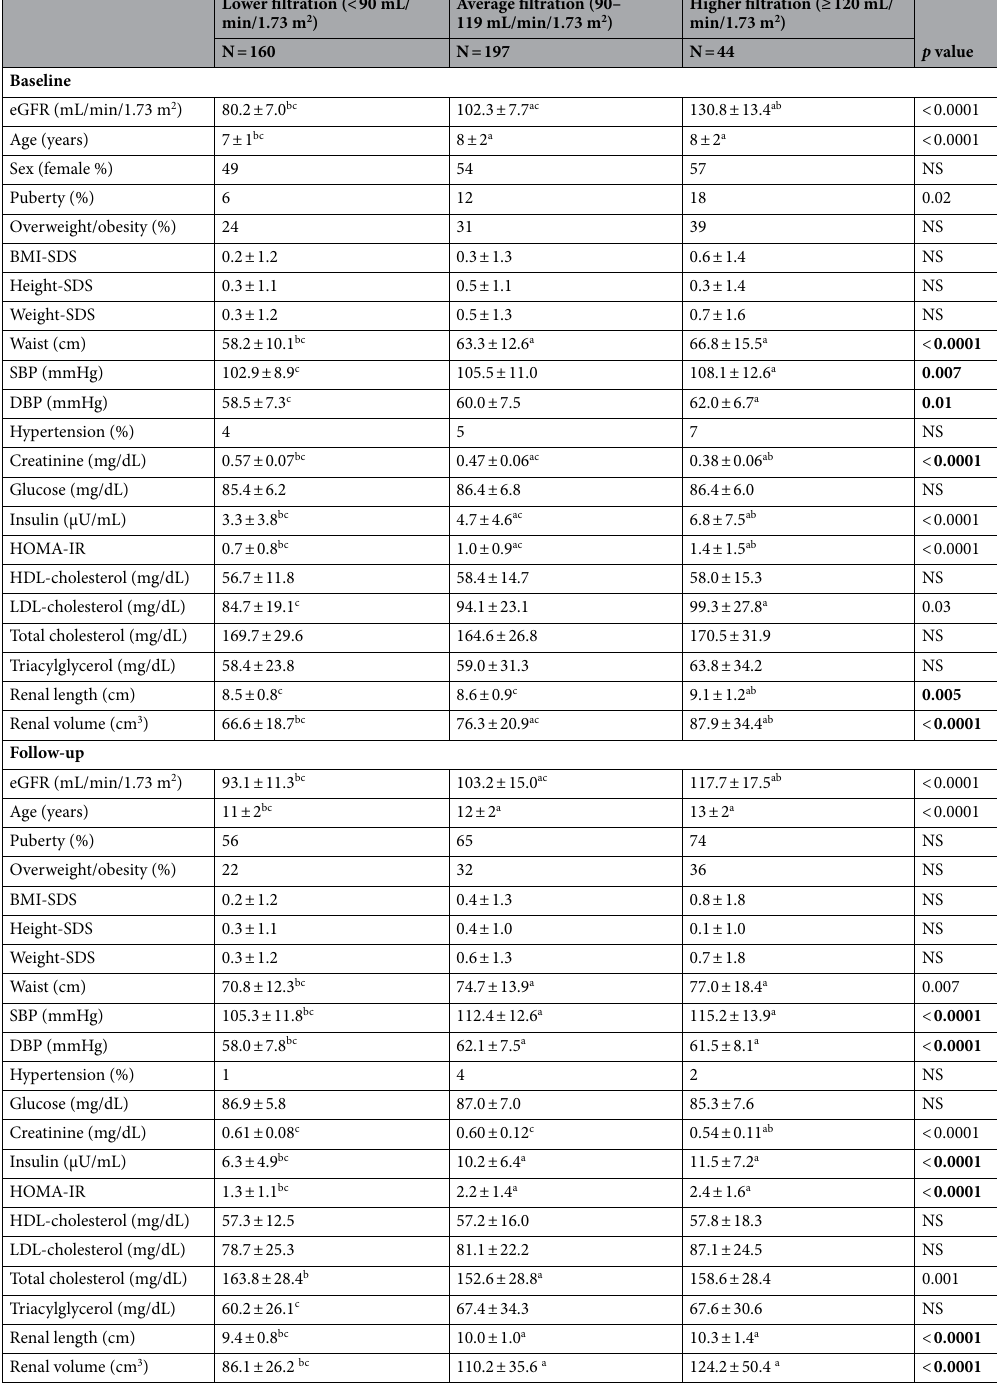
Table 4. Clinical, laboratory, and ultrasonography assessments at baseline and follow-up according to baseline eGFR categories. Data is presented as mean ± standard deviation (SD), or n (%). BMI body mass index, SBP systolic blood pressure, DBP diastolic blood pressure, eGFR glomerular filtration rate, HOMA-IR homeostatic model assessment of insulin resistance, NS non-significant. Continuous variables are compared with the ANOVA and the Bonferroni test, and proportions are compared with the chi-square. a p < 0.05 compared to lower filtration. b p < 0.05 compared to average filtration. c p < 0.05 compared to higher filtration. Significant after adjustment for pubertal stage, sex, age, and BMI in univariate general linear models are shown in